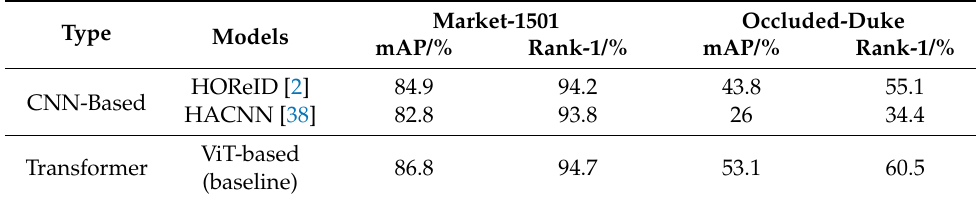
Table 4. Comparison results of Transformer architecture and CNN-based architecture.